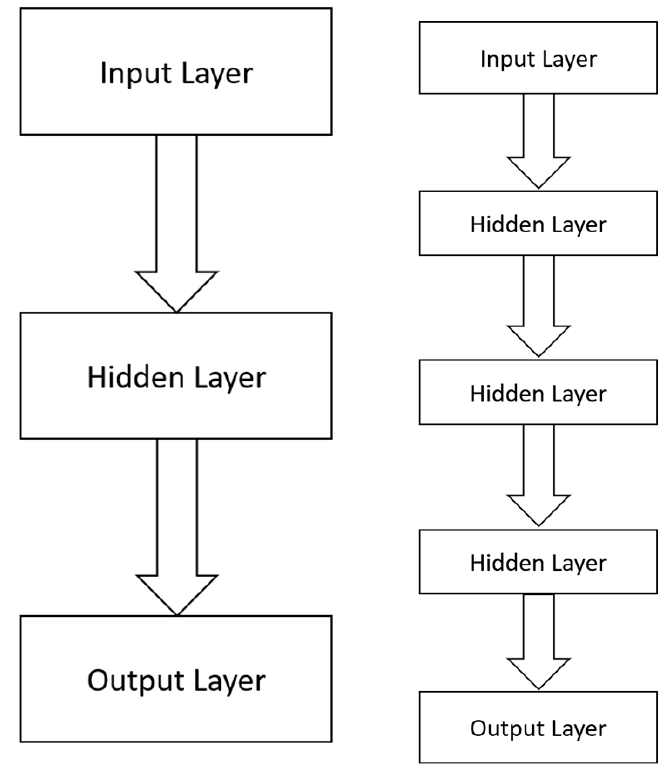
Figure 2. Diagrams of a shallow neural network ( left ) and of a deep neural network ( right ) model. The former consists of a single hidden layer, as opposed to the latter, which consists of more than one hidden layer, specifically three, as described in the case study